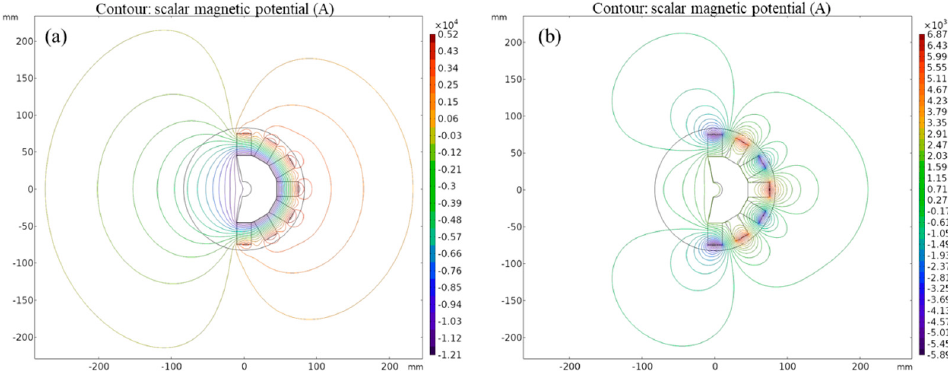
Figure 14. Comparison of distribution of magnetic lines of force between N-N arrangement ( a ) and N-S arrangement ( b ) ( 𝐵 (cid:3045) = 1.2 T).